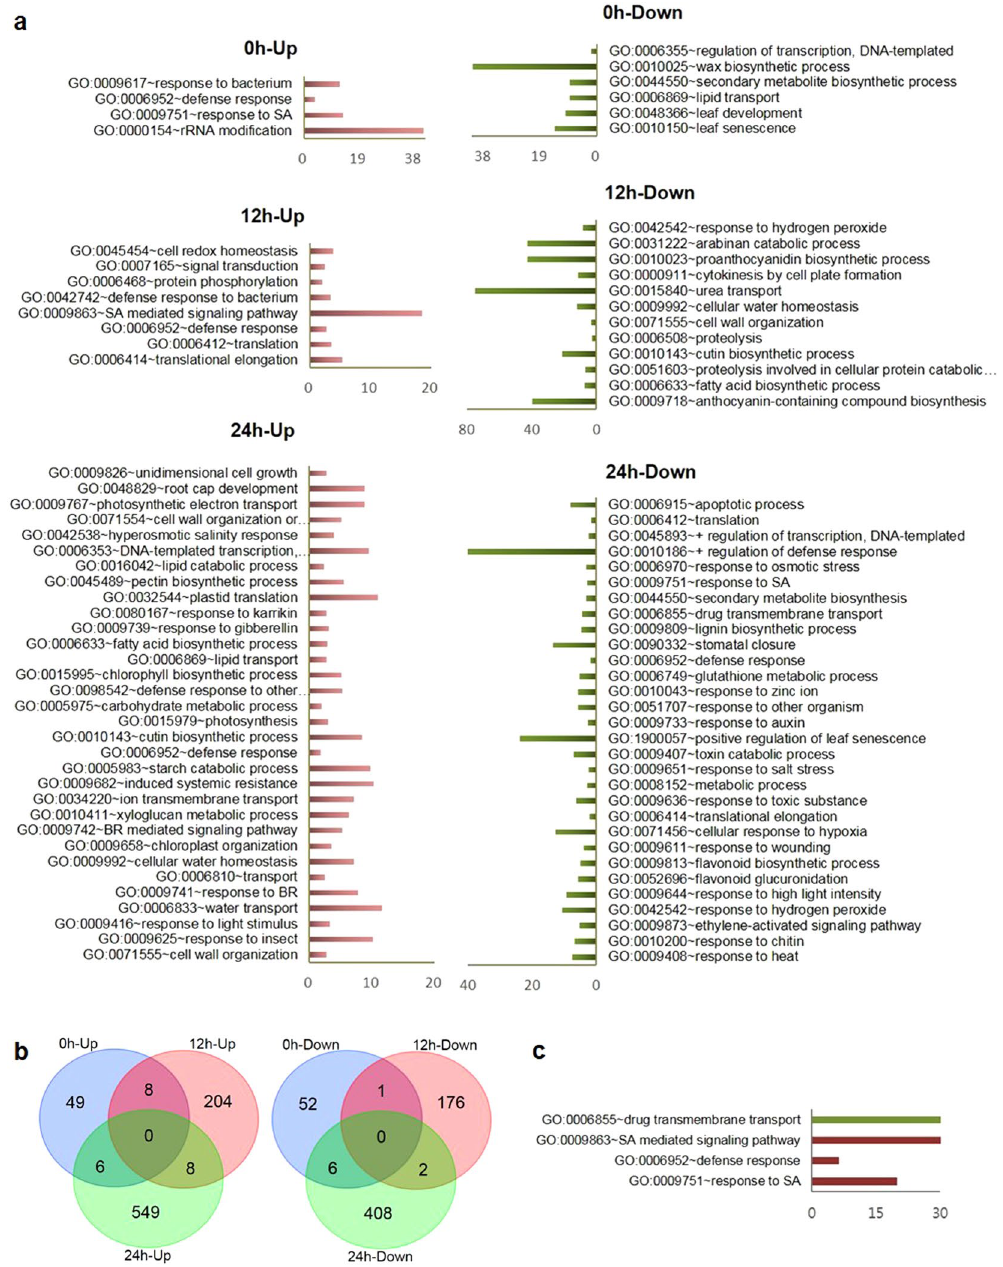
Figure 2. Gene ontology enrichment analysis of the differentially expressed genes after infection with B . cinerea in A . thaliana exposed to 1000 Hz sound vibration. ( a ) The differentially expressed genes ( P < 0.05, fold change > 1.5) were categorized according to gene ontology (GO) biological process. The detailed analyses of all GO classes are available in Supplementary Table S1. ( b ) Venn diagram represents the number of overlapping genes between the analyzed time points. The time (0, 12, and 24 h) indicates h post inoculation (hpi). Up and down indicate the up- and down- regulated genes respectively at given time points. ( c ) Enriched GO of biological process within the list of genes found to be common at least in two different time points. Red and green color bars indicate up- and down- regulated genes, respectively. GO enrichment analysis was performed through DAVID bioinformatics resources at P < 0.05. Microarray analysis was performed with three biological